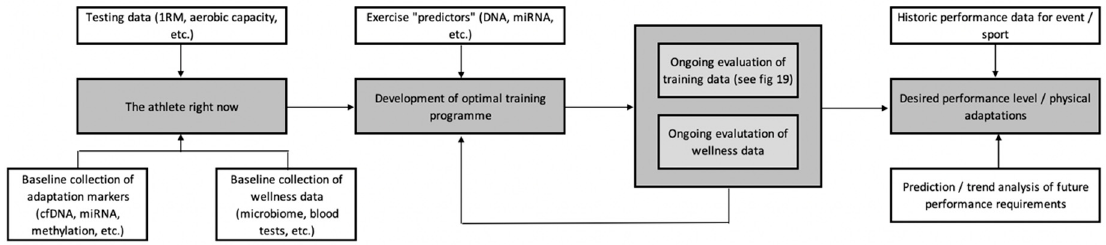
Figure 2. An overview of the development of the personalised training process.